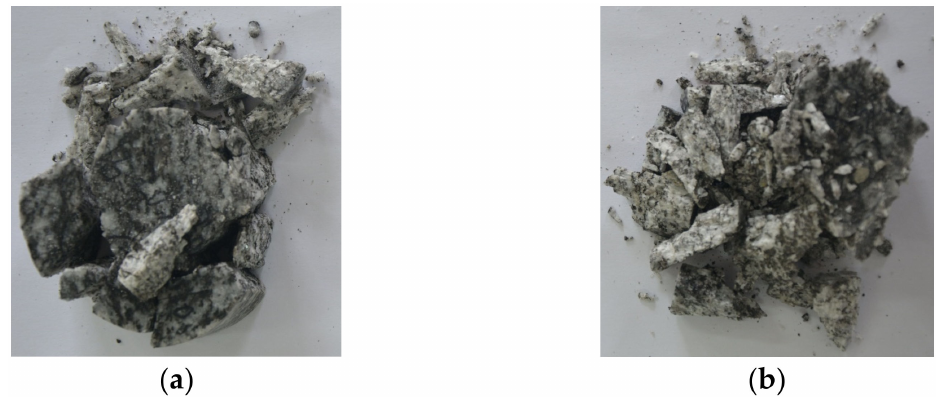
Figure 7. Failure mode of the granite under different water condition. ( a ) water-saturated granite ( b ) natural air-dried granite.